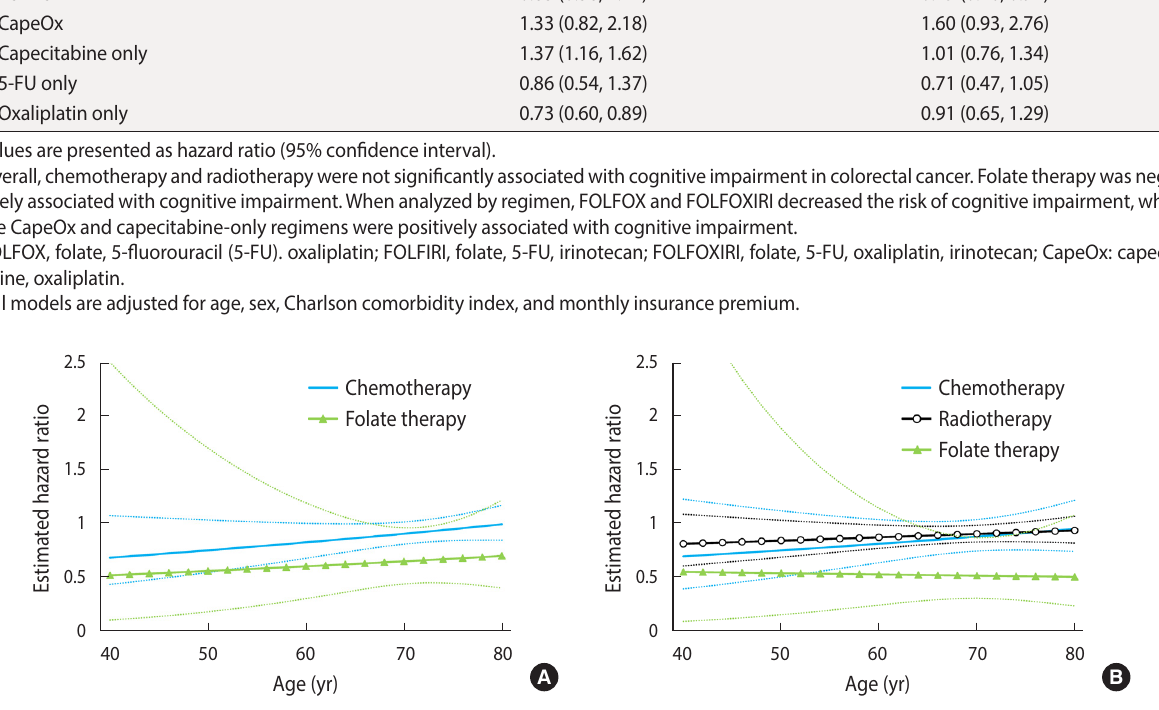
Figure 2. Age-specific hazard ratios of chemotherapy and radiotherapy for cognitive impairment (A) colon cancer and (B) rectal cancer.